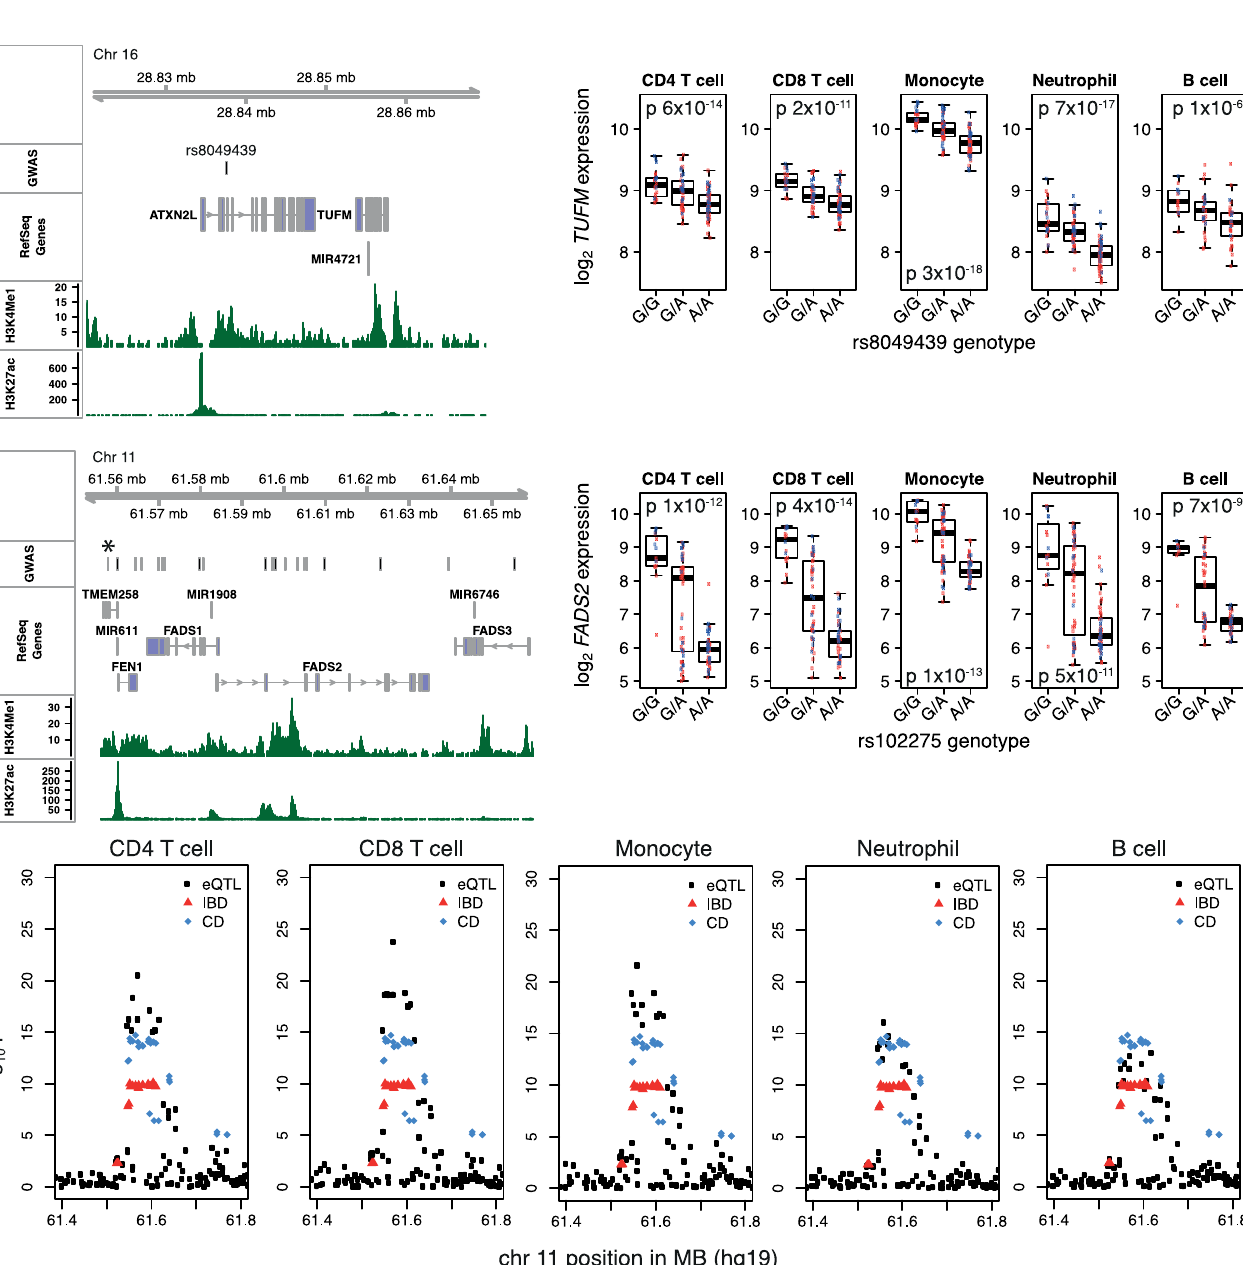
Fig 6. Multiple cell-type analysis provides new insights into effects of IBD-associated SNPs on gene expression. (A) An intronic SNP in ATXN2L associated with early-onset IBD is an eQTL for TUFM in all cell types examined (FDR < 0.0001). Left: Genomic features in the region showing position of the disease-associated SNP, nearby genes, and ENCODE histone marks. Right: eQTL boxplots. Red and blue points indicate IBD patients and HVs respectively. (B) An IBD-associated SNP, rs102275, is an eQTL for FADS2 . Left: genomic features in the region. “ GWAS ” indicates disease-associated SNPs from NHGRI GWAS catalogue. * position of rs102275. Right: Crohn ’ s disease (CD) risk allele (G) is associated with increased FADS2 expression. P- values calculated from score tests. Below: Manhattan plots showing FADS2 eQTL association signal (black), and IBD and CD association signals from the meta-analysis by Jostins et al [17]. eQTL p-values are from linear regression of expression on genotype with disease status as covariate ( lm function in R).